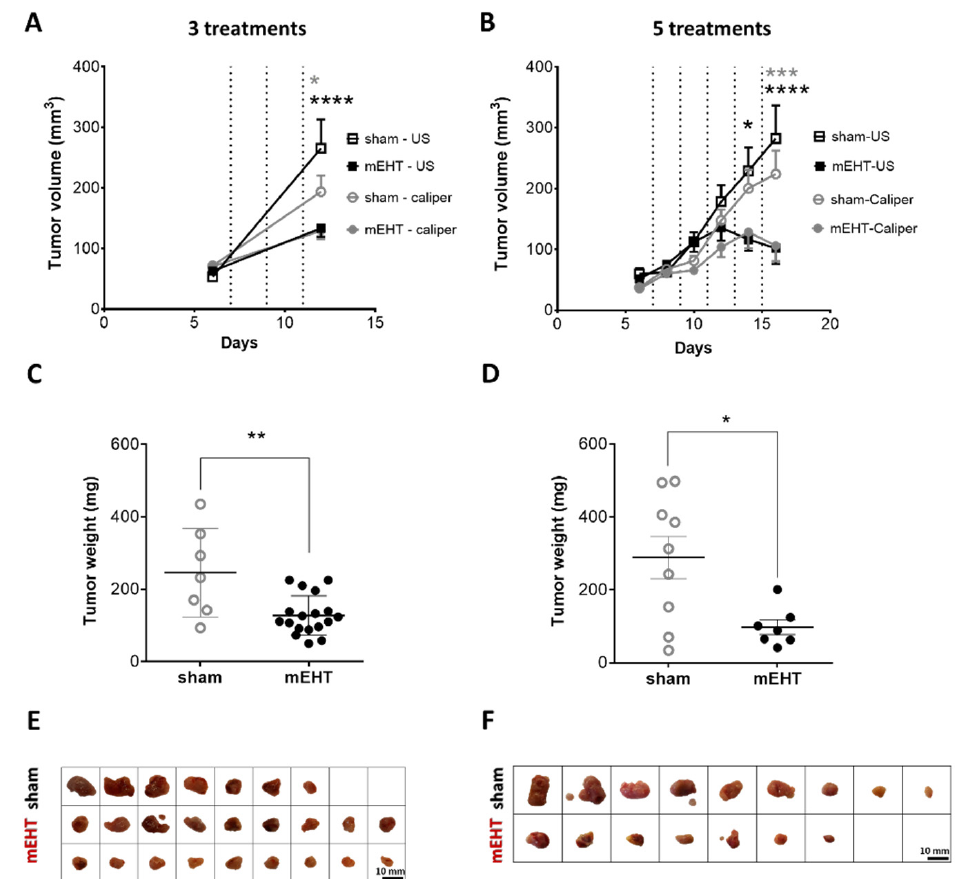
Figure 1. Effect of repeated modulated electro-hyperthermia (mEHT) treatments on tumor size and weight. Digital caliper and ultrasound data after three ( A , C , E ) and five ( B , D , F ) treatments (dotted lines, A , B ). Tumor weight ( C , D ), scale images of the excised tumors ( E , F ). ( A – E ) n (sham) = 7, n (mEHT) = 18. ( B – F ) n (sham) = 9, n (mEHT) = 7. Mean ± SEM, ( A , B ) two-way ANOVA, Bonferroni correction, ( C , D ) Mann-Whitney test, *: p < 0.05, **: p < 0.01, ***: p < 0.001, ****: p < 0.0001. Cell line: 4T07, 3–5× treated.